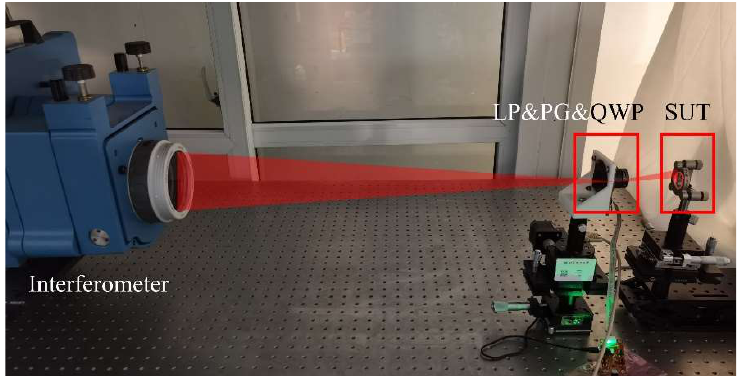
Figure 10. Experimental setup of PG-CSSI. LP is the linear polarizer. PG is the polarization grating. QWP is the λ/4 wave plate. SUT is the surface under test.